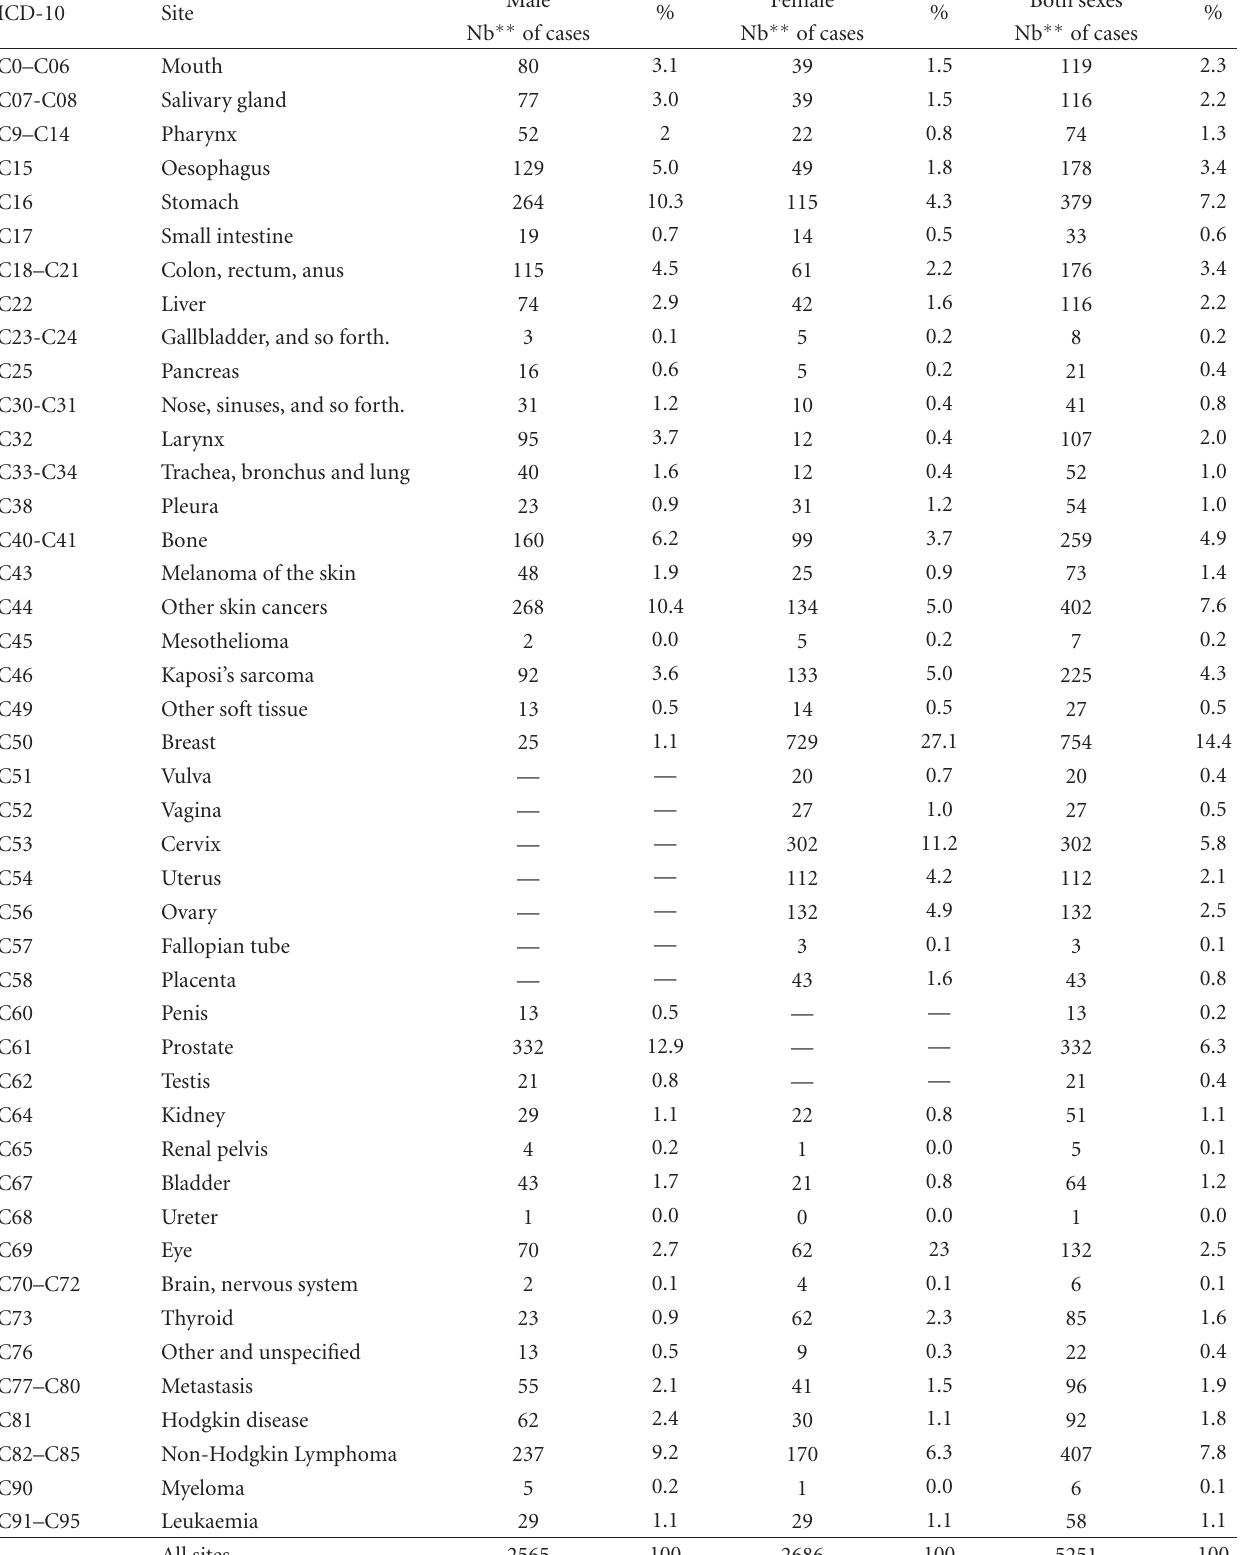
Table 1: Distribution of cancers by site and